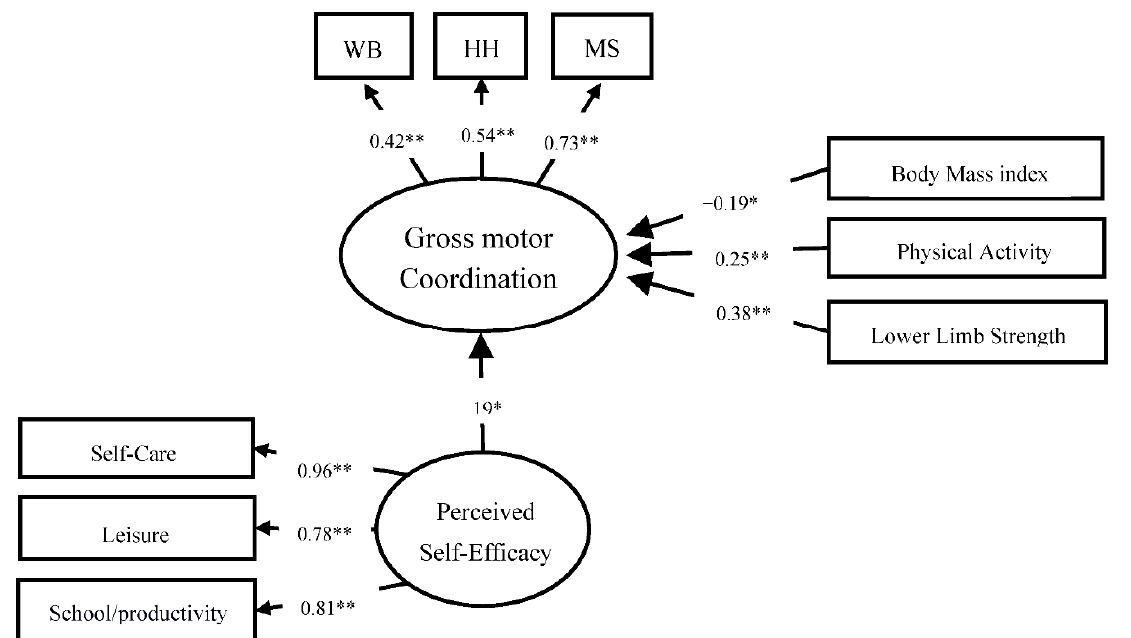
Figure 1. Children with DCD motor coordination model: BMI, PA, lower limb strength, and self- efficacy. Note: WB: walking backward along a balance beam; JS: jumping sideways over a slat; HH: hopping for height on one foot; MS: moving sideways on boards. * Statistically significant at p < 0.05. ** statistically significant at p < 0.001.